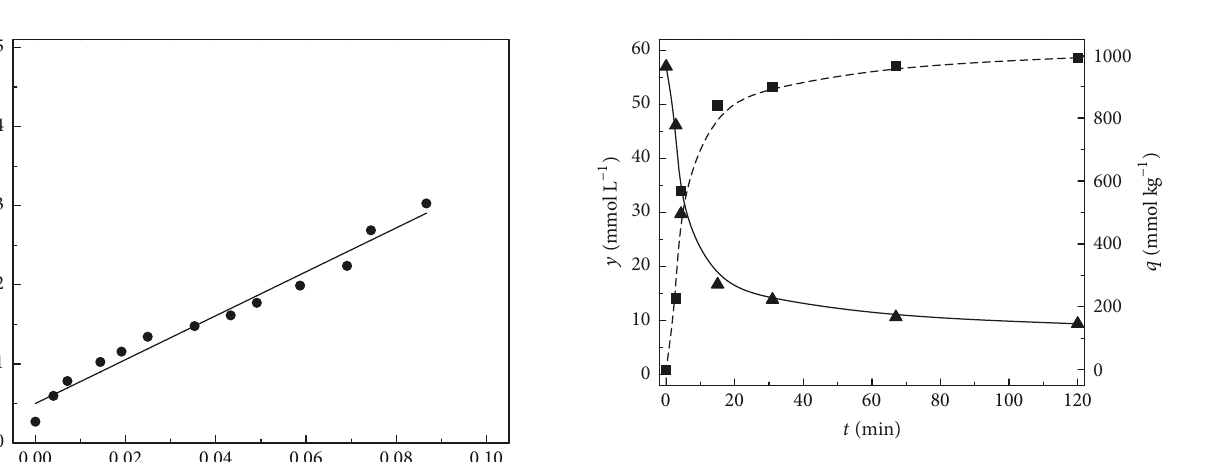
Figure 6: Concentration of oleic acid in both the liquid phase ( 𝑦 , 󳵳 ) and solid phase ( 𝑞 , ◼ ) as a function of time. Packed column with fast recycle, 30 ∘ C. Granular activated carbon, average pellet diameter, 0.4 mm.